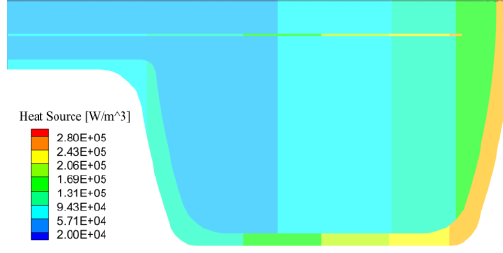
Figure 5. Distribution of internal heat source. Table 1. Comparison of simulation results between CFX and MCNPX